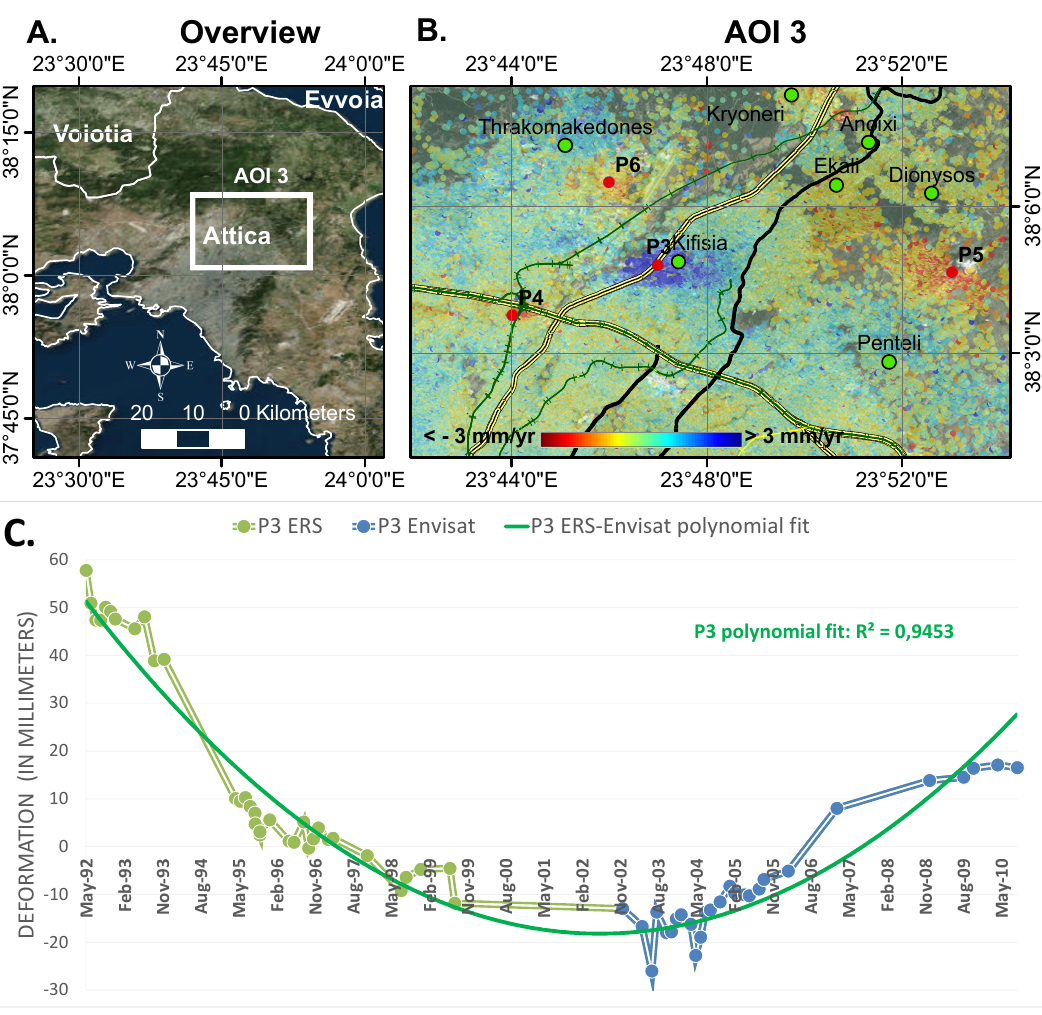
Figure 6. Zoom in the northern suburbs of Athens for the 2002–2010 time series analysis. ( A ) Overview of the study area and selected AOI; ( B ) the velocity field in AOI3 based on descending track T465 data, since it contains the most image acquisitions; scatterers P3, P4, P5 and P6 mentioned in the text are also shown; ( C ) deformation history of scatterer P3 in Kifisia, plotting the 1992–1999 period, as well (Figure 5D). In the period 2002–2010, a change in the LOS motion direction is observed with respect to the 1992–1999 period, moving from subsidence to uplift. For the entire analysis period, spanning from 1992–2010, a polynomial function fits the estimates best, consistent with our non-linear motion assumption for